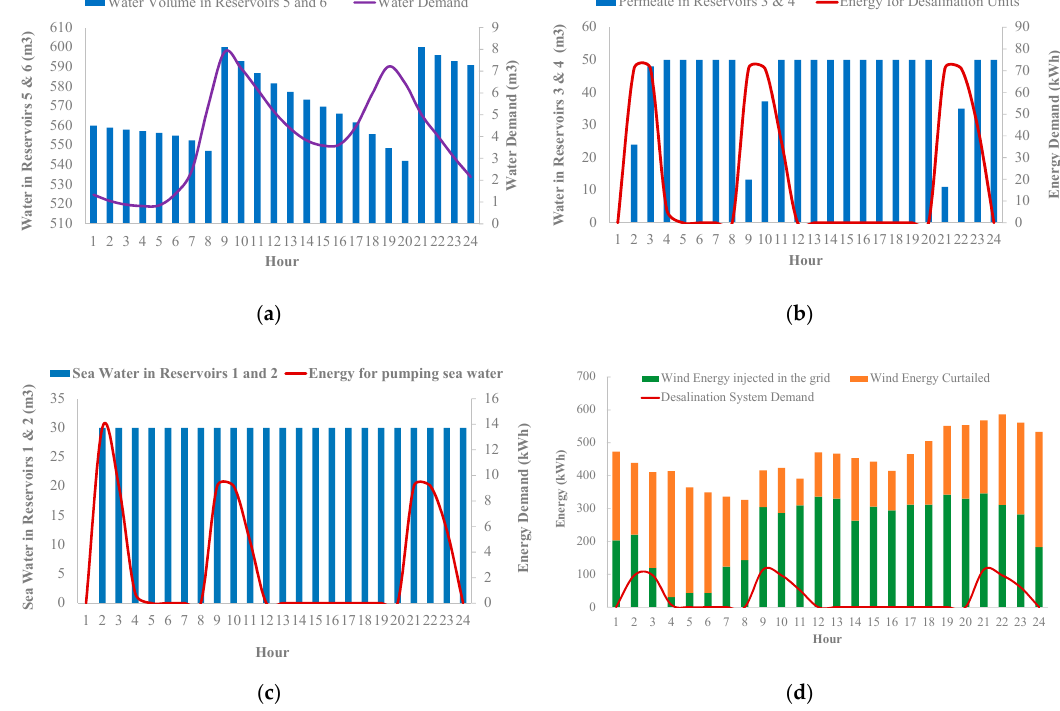
Figure 6. Conventional operation of the desalination system for the first day of the examined year: ( a ) Volume of water in the clear water reservoirs and the relevant water demand, ( b ) energy demand of the desalination units and volume of permeate water, ( c ) energy demand for pumping sea water and the relevant volume of sea water in reservoirs 1 & 2, ( d ) Curtailment of the wind production & desalinations system demand.